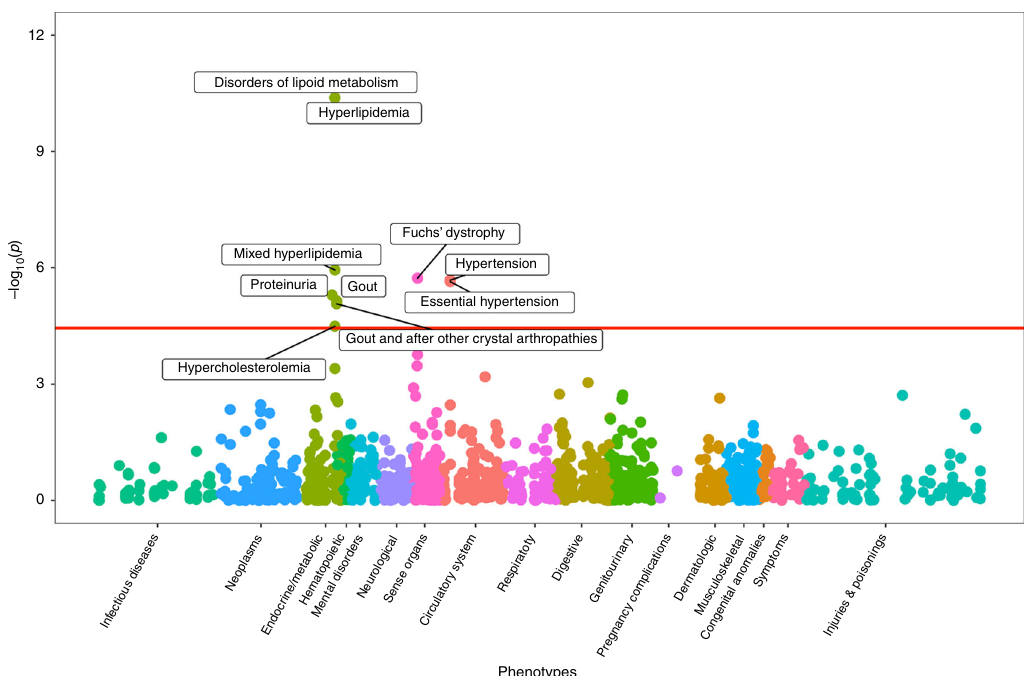
Fig. 3 Phenome-wide association scan of a genetic urinary albumin-to-creatinine ratio (UACR) risk score. PheWAS association results were obtained from EA participants of the Million Veteran Program. Association test -log 10 ( p -values) are plotted on the y -axis, and the corresponding trait or disease category on the x -axis. Signi fi cant results, after correcting for the 1422 phenotypes tested ( p < 0.05/1422 = 3.5 × 10 − 5 ), are labeled in the fi gure